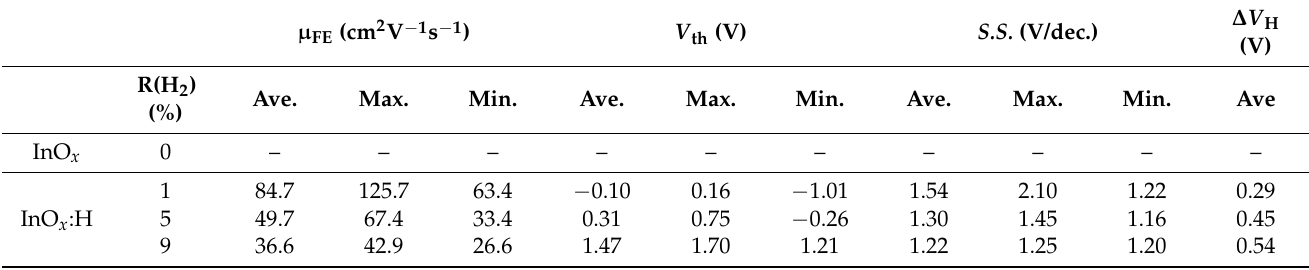
Figure 9. Variations of ( a ) μ FE , ( b ) V th , ( c ) S.S. , and ( d ) V H evaluated from seven TFTs. Table 2. Summary of TFT parameters extracted from seven TFTs on same